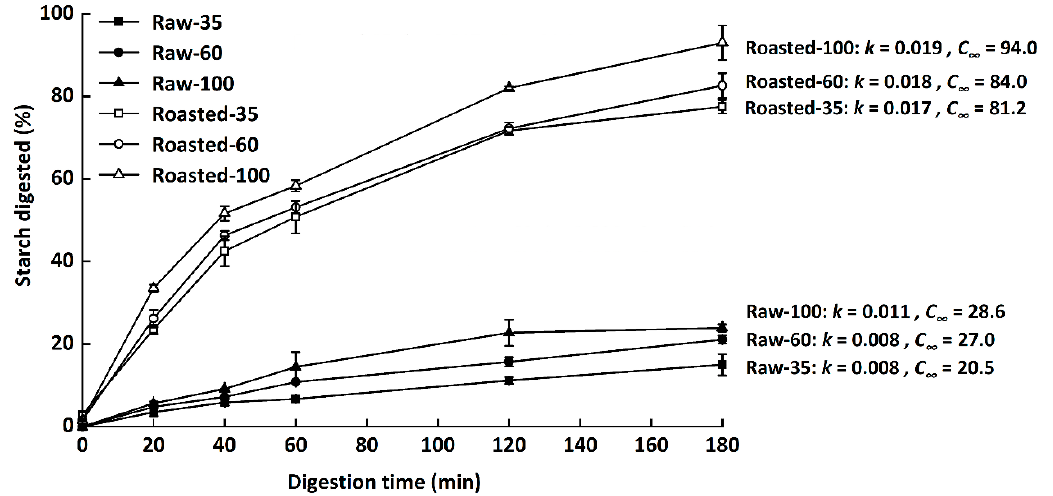
Figure 5. In vitro starch digestion curves of raw and sand-roasted highland barley flours. Raw-35, Raw-60, and Raw-100 indicate raw highland barley flour as coarse (250–500 μ m), medium (150–250 μ m), and fine (<150 μ m) fraction, respectively; while Roasted-35, Roasted-60, and Roasted-100 indi- cate sand-roasted highland barley flour as coarse (250–500 μ m), medium (150–250 μ m), and fine (<50 μ m) fraction, respectively. k , the kinetic constant; C ∞ , maximal equilibrium concentration.